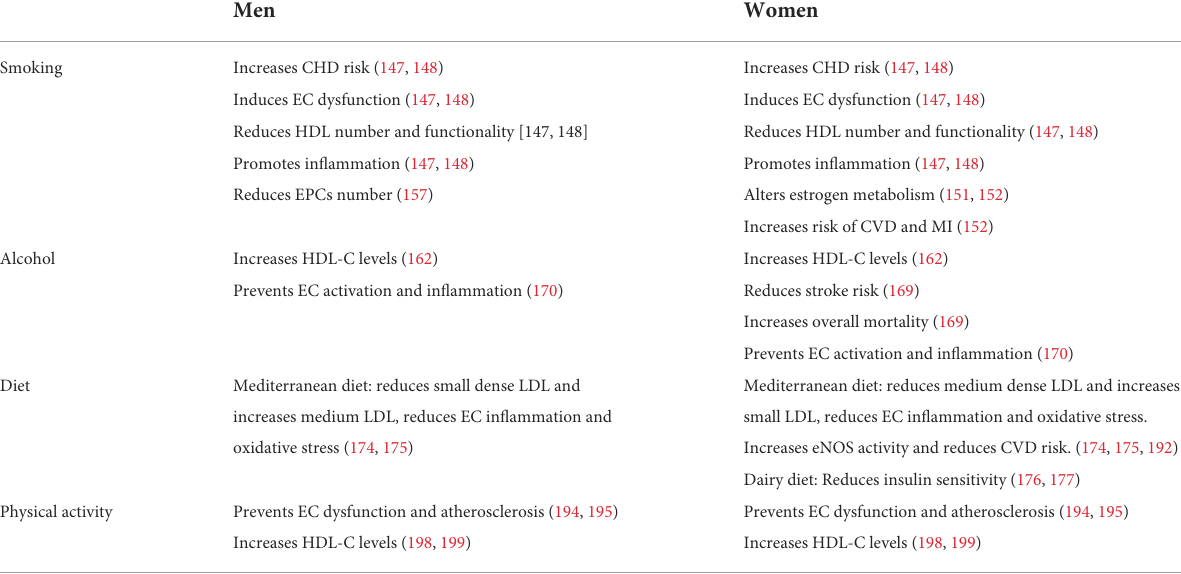
TABLE 1 Comparative description of the effect of lifestyle habits on HDLs and ECs in men and